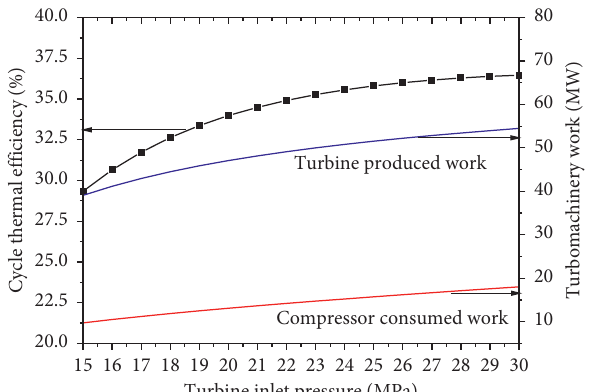
Figure 9: Effects of TIP on the cycle thermal efficiency for